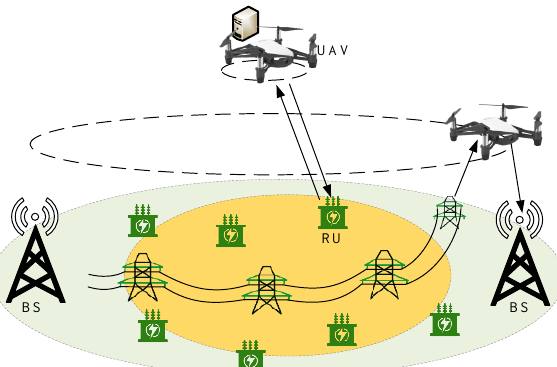
Figure 1. Network Figure 1. Network scenario.